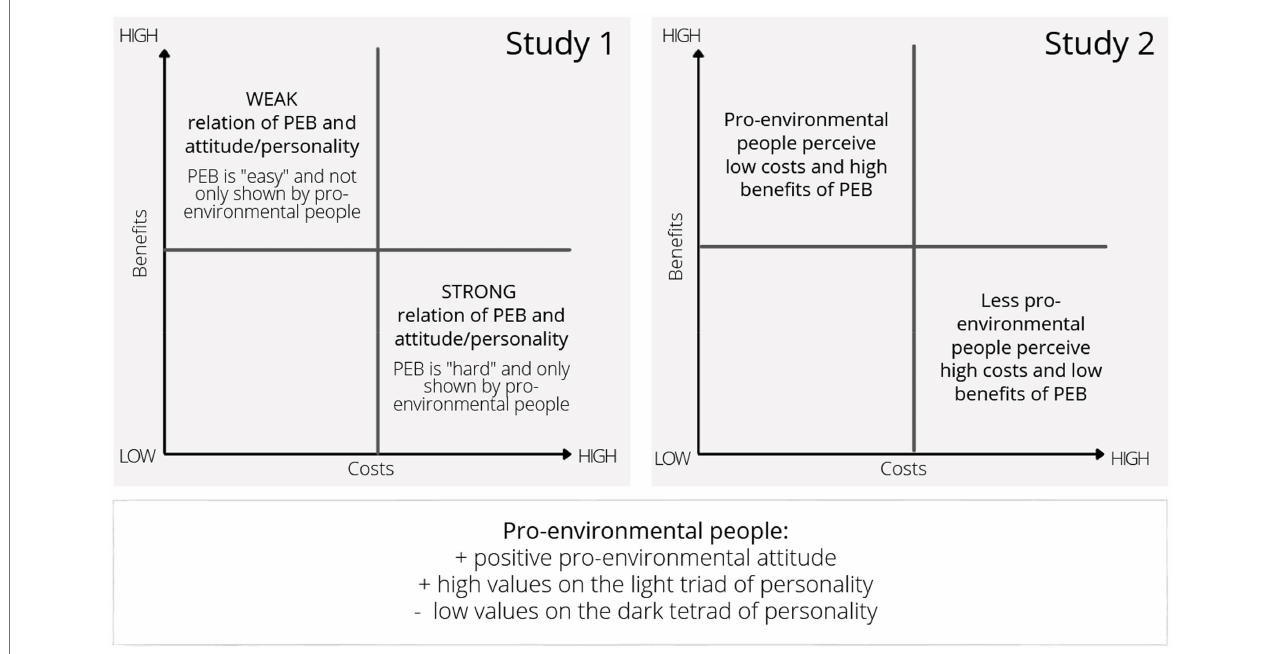
FIGURE 1 | Summary of the studies’